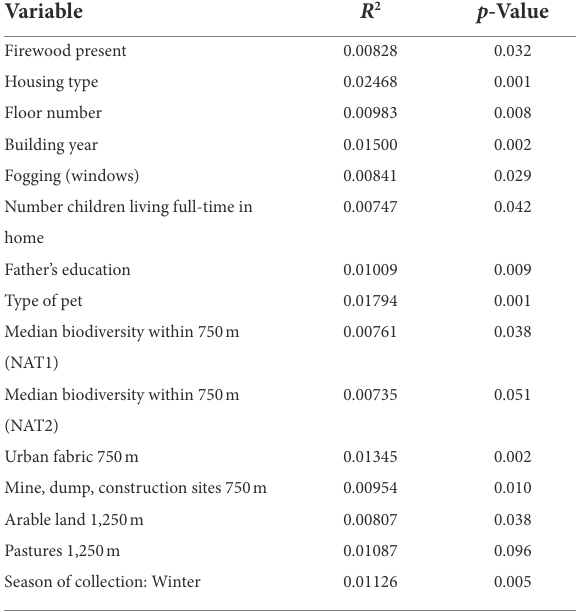
TABLE 2 Fungal association results ( R 2 and p -value) for genus-level data (see Table 1).